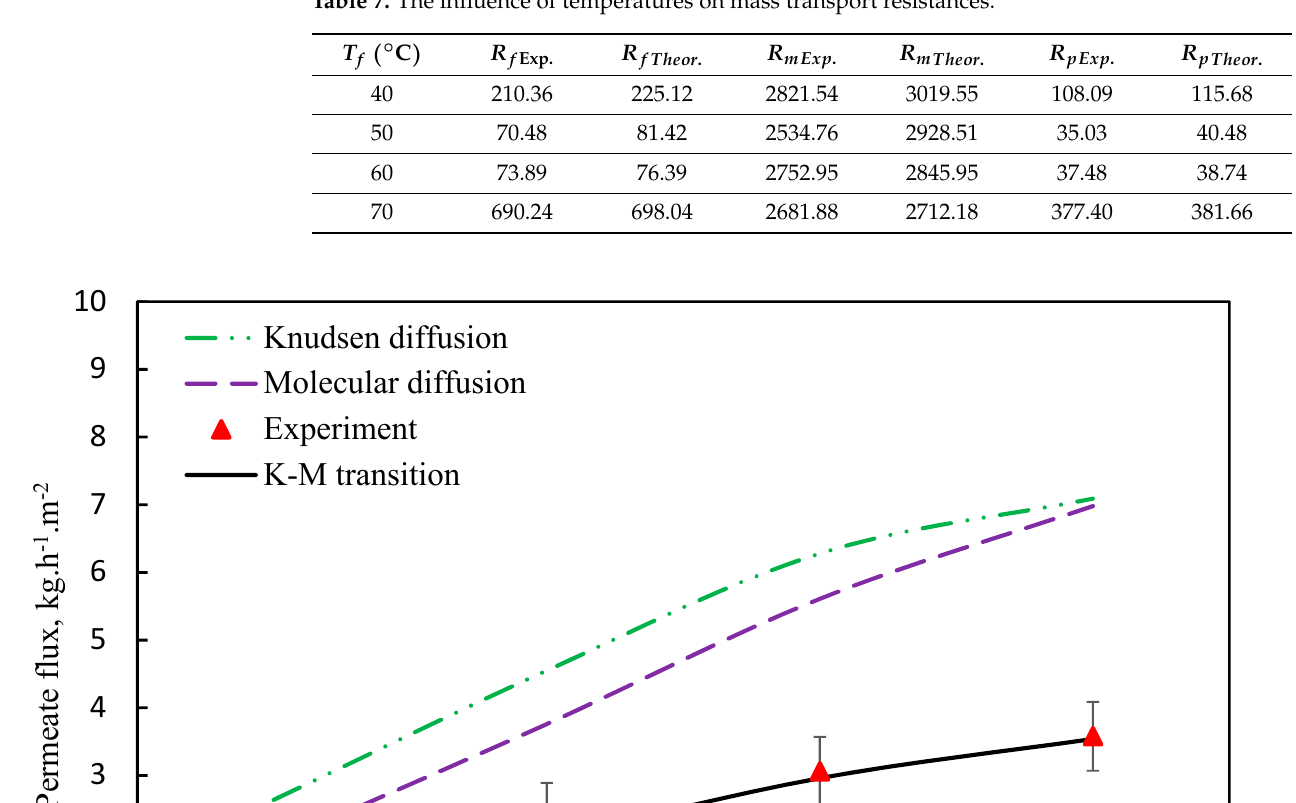
Table 7. The influence of temperatures on mass transport resistances.